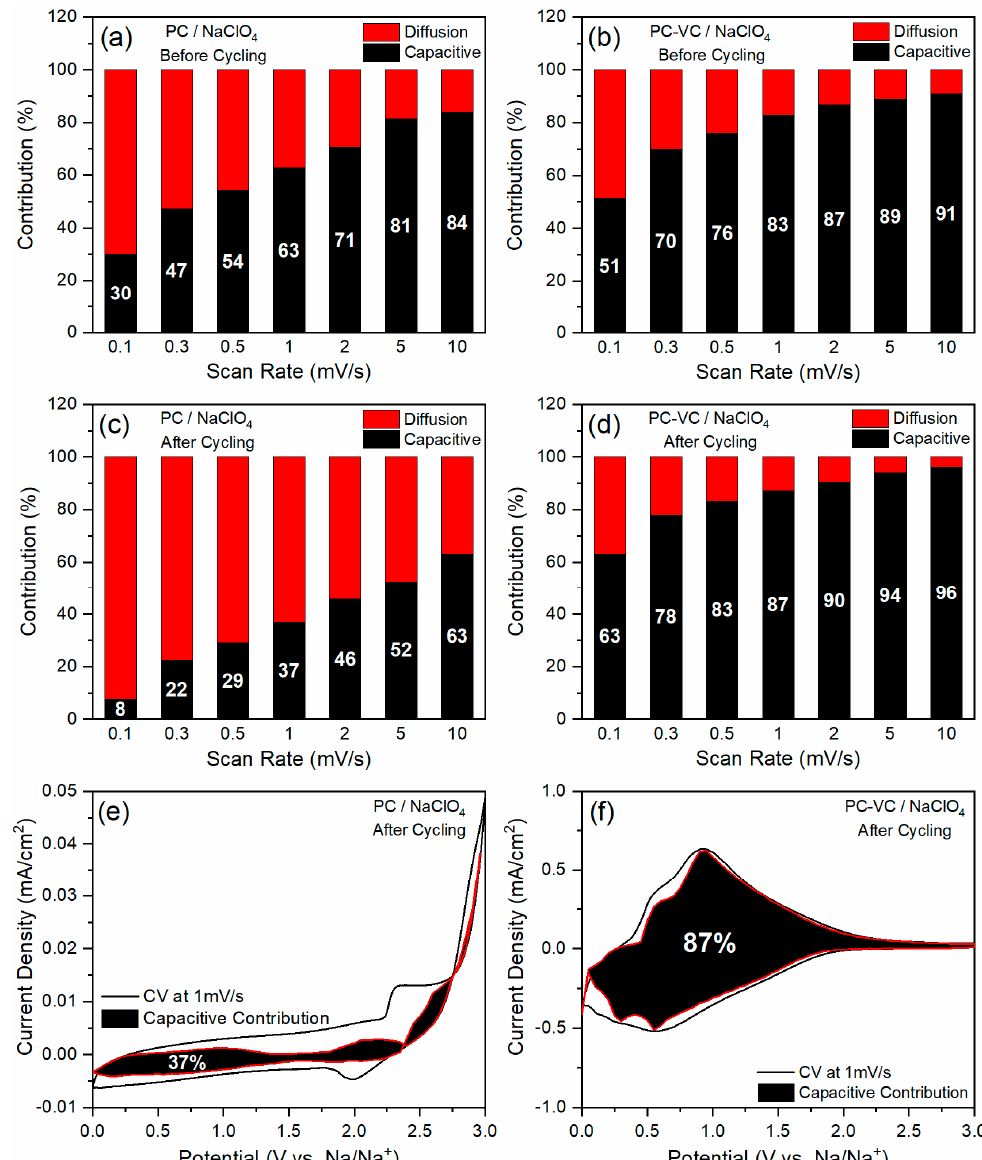
Figure 6. Pseudocapacitance contributions of the TiO 2 nanosheet anodes ( a , b ) before cycling, and ( c , d ) after cycling in PC / NaClO 4 and PC-VC / NaClO 4 electrolyte solutions. Pseudocapacitance contributions at a scan rate of 1 mV/s after 30 cycles in ( e ) PC / NaClO 4 , and ( f ) PC-VC / NaClO 4 electrolyte solutions.